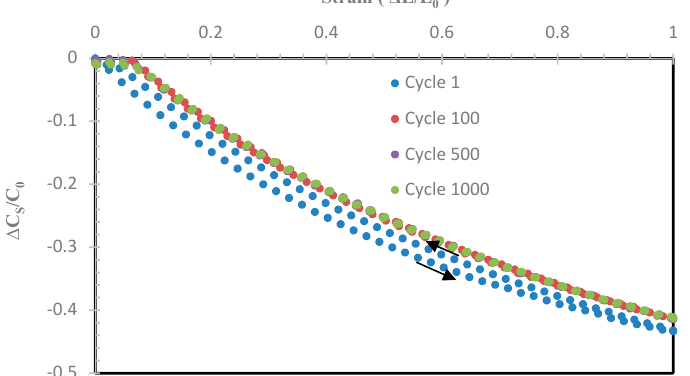
Figure 9. The relative change in capacitance strained up to 100% after 1, 100, 500 and 1000 stretch/relax cycles.